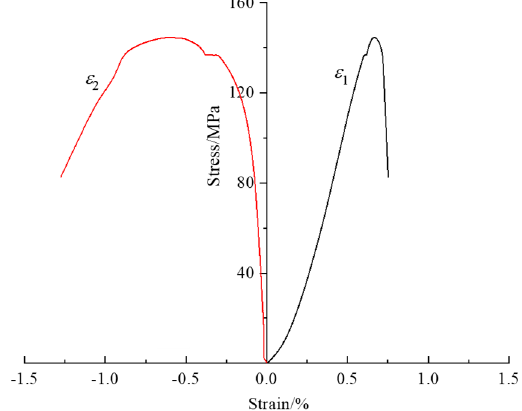
Figure 3. Stress − strain curves in the uniaxial compression test.